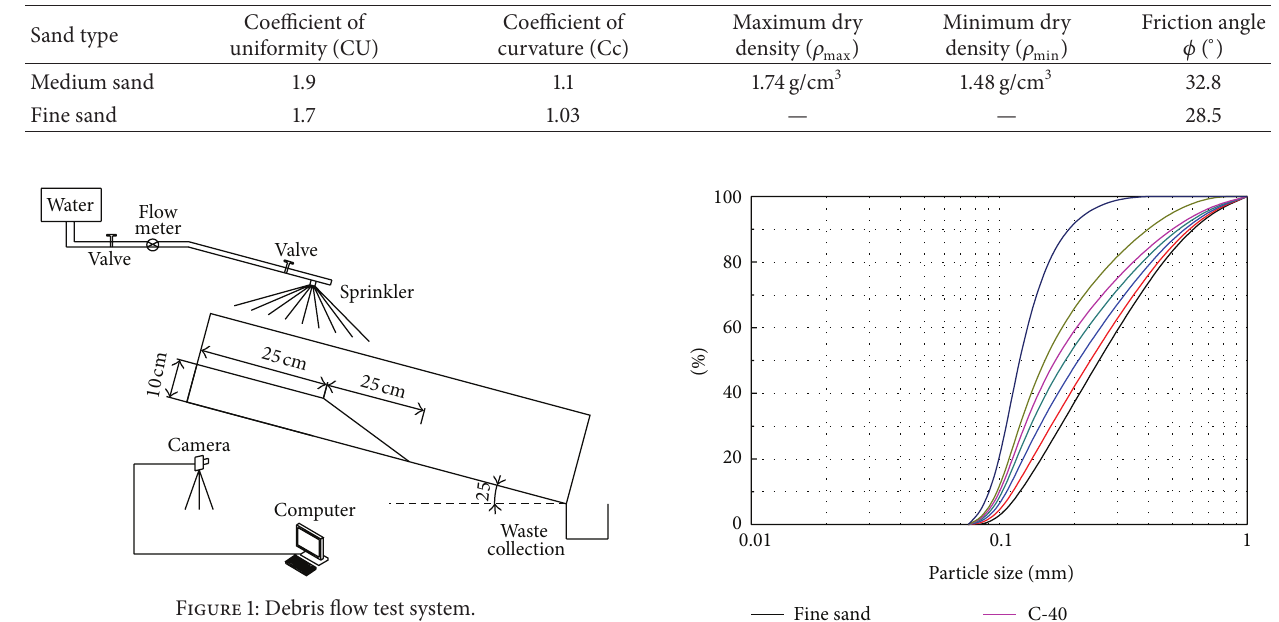
Table 1: Physical indices of the sand samples.